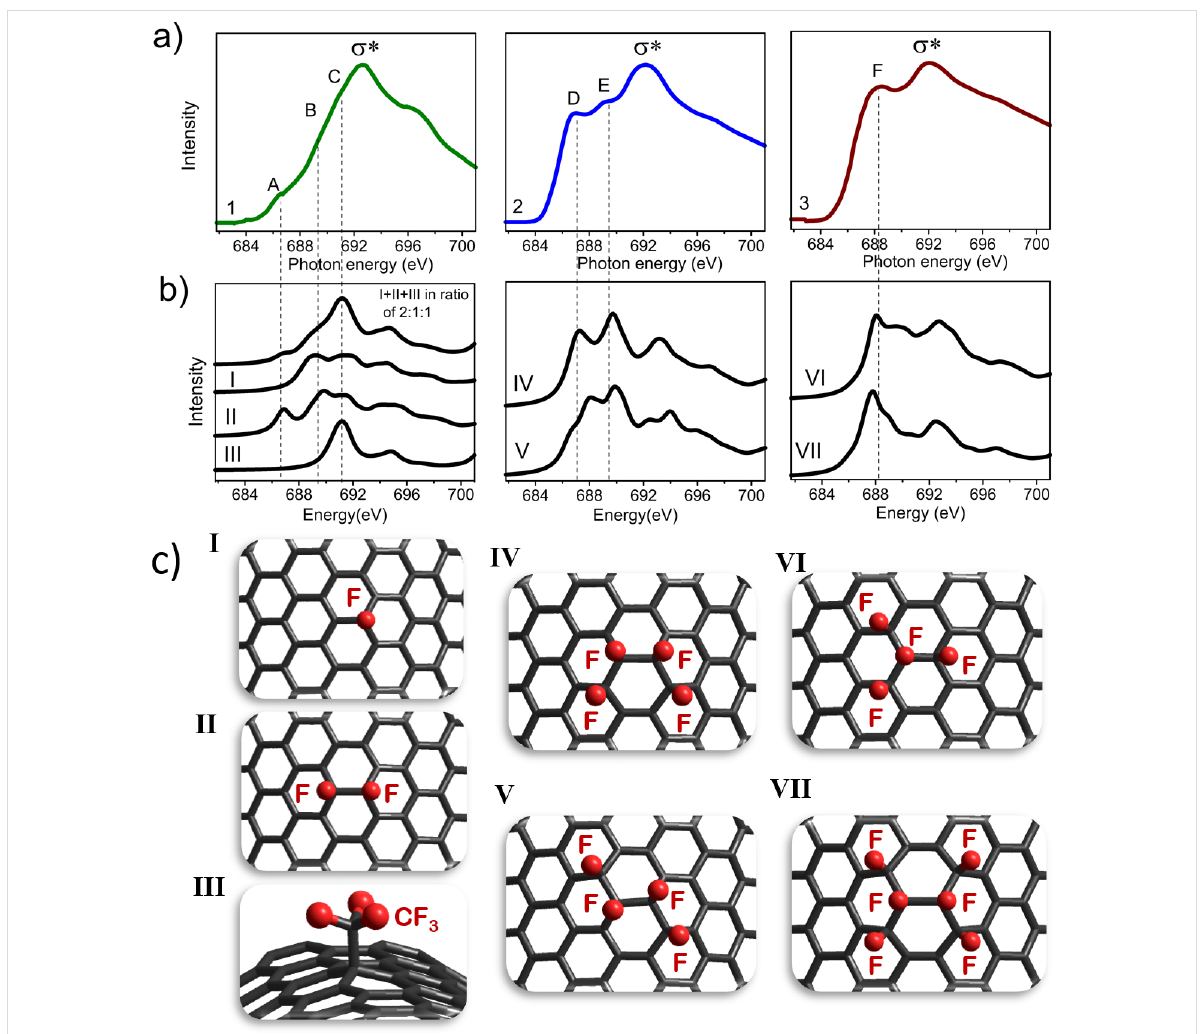
Figure 4: (a) Experimental F K-edge NEXAFS spectra for DWCNTs fluorinated with CF 4 plasma (1), BrF 3 (2) and F 2 (3). (b) Theoretical F K-edge spectra calculated for all F atoms in models (c) distinguished by fluorination pattern. The curve above the theoretical spectra plotted for models I, II and III is their combination in a ratio of